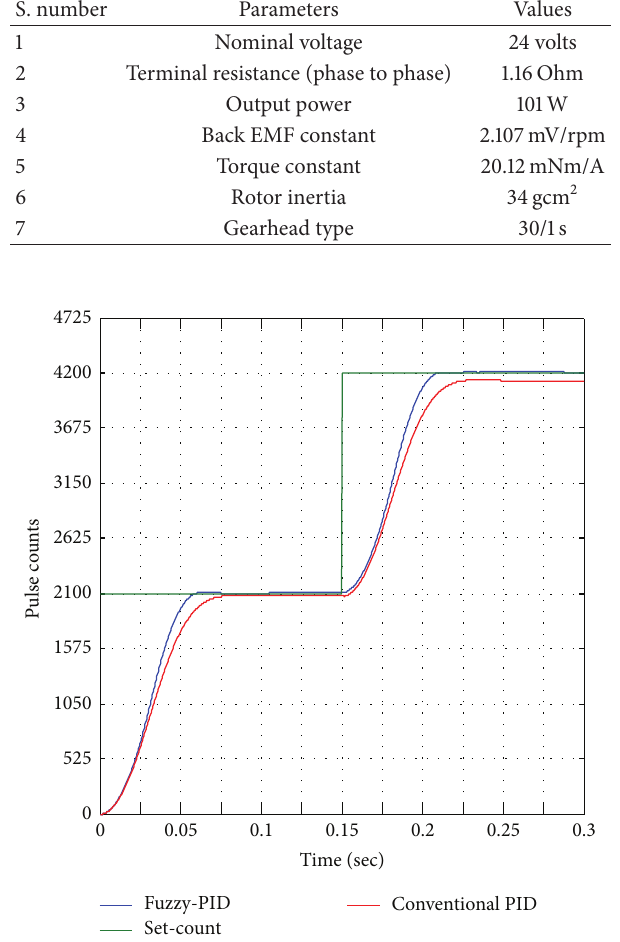
Figure 18: Step change from 2100 to 4200 pulse